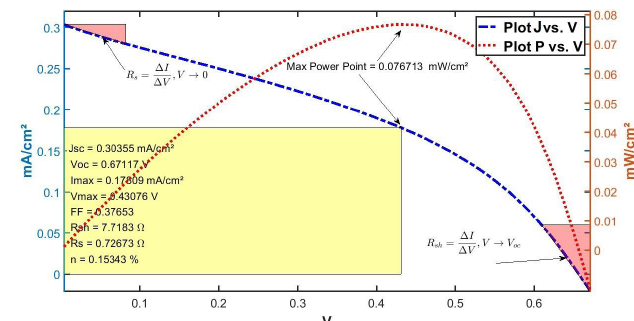
Figure 12. I – V curves for CdS / CdTe solar cells with addition of PANI. Source: the